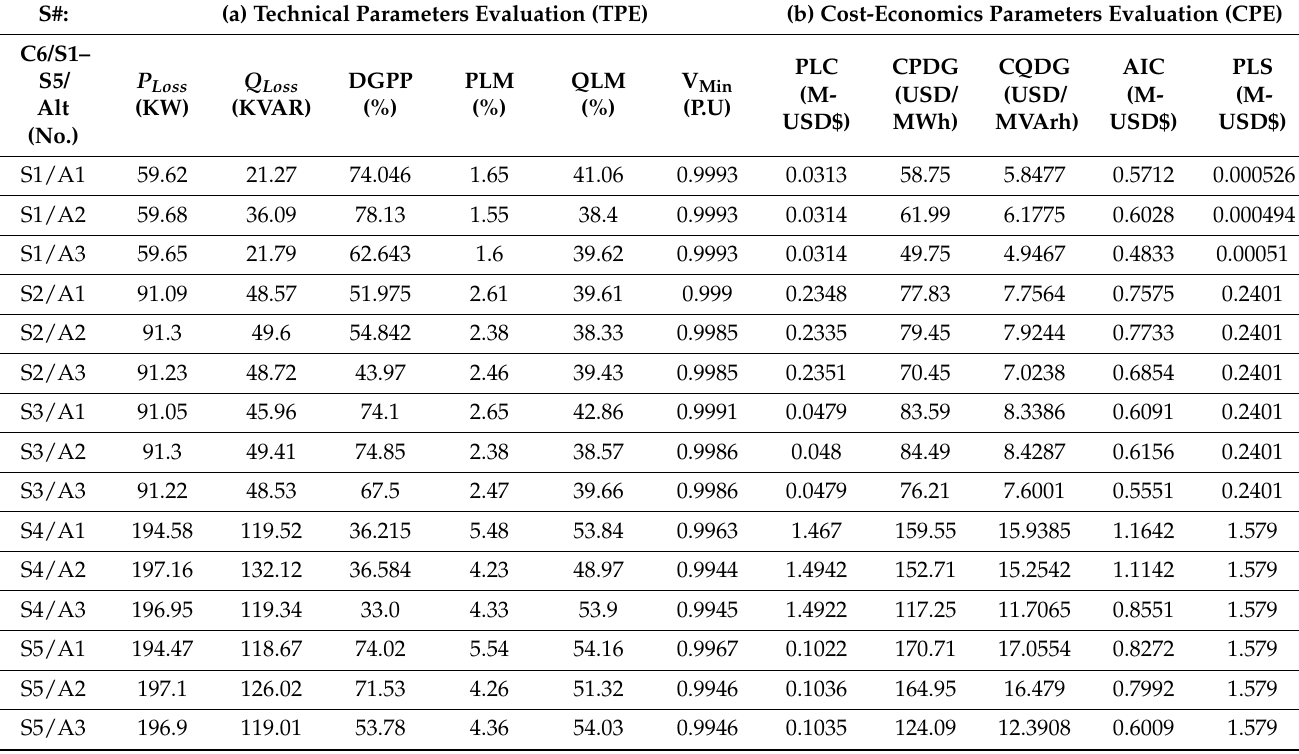
Table 26. TPE/CPE evaluations in C6/S1–S5 for the 75-bus MDN NUST_MG for DG + DSTATCOM.